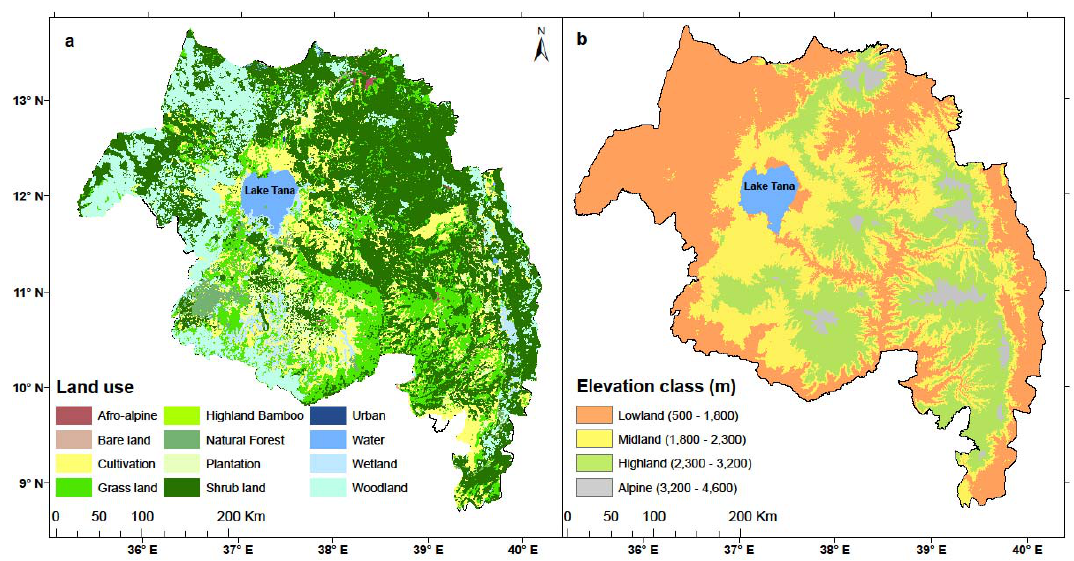
Figure 1. ( a ) Land use, provided by the Bureau of Agriculture [37], and ( b ) elevation class (30 m by 30 m resolution) in the Amhara region in Ethiopia.